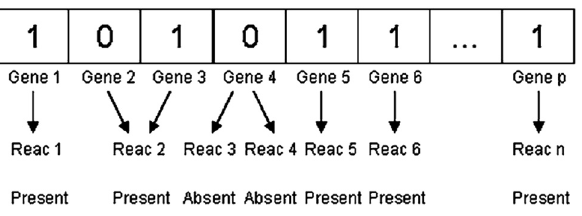
Figure 3: The representation of bat representation of metabolic genotype. Reac represents